Question: Give a one-sentence summary of this figure.
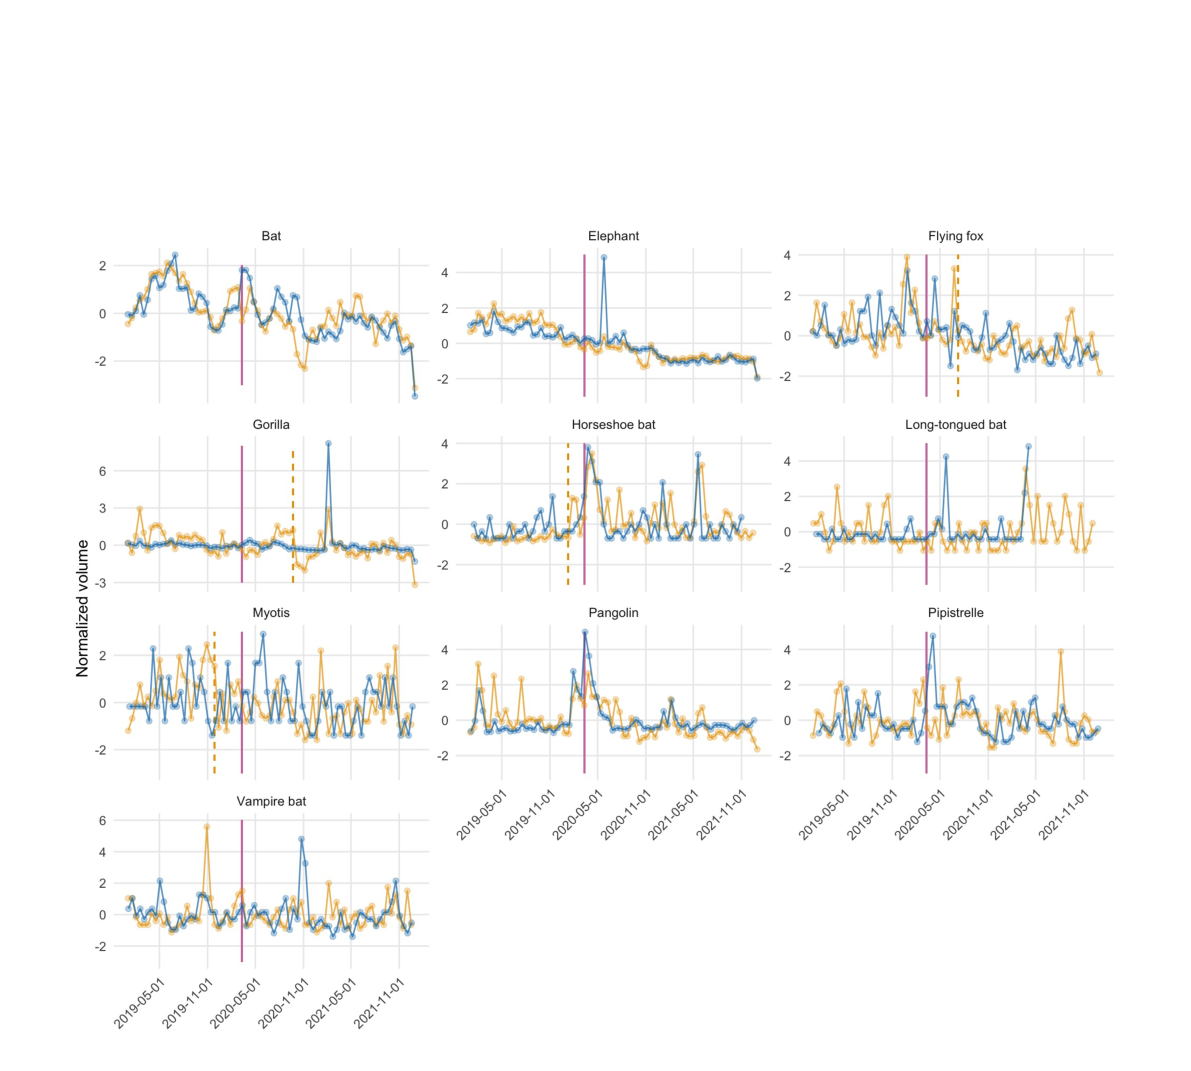
Answer: Changes in volume through time. The solid vertical magenta line denotes March 11, 2020, which was the date when the UN WHO declared COVID19 a pandemic. The dashed vertical orange or blue lines correspond to any significant breakpoints in the trend for GDELT or Twitter respectively, after conducting Bonferroni family-wise error correction.